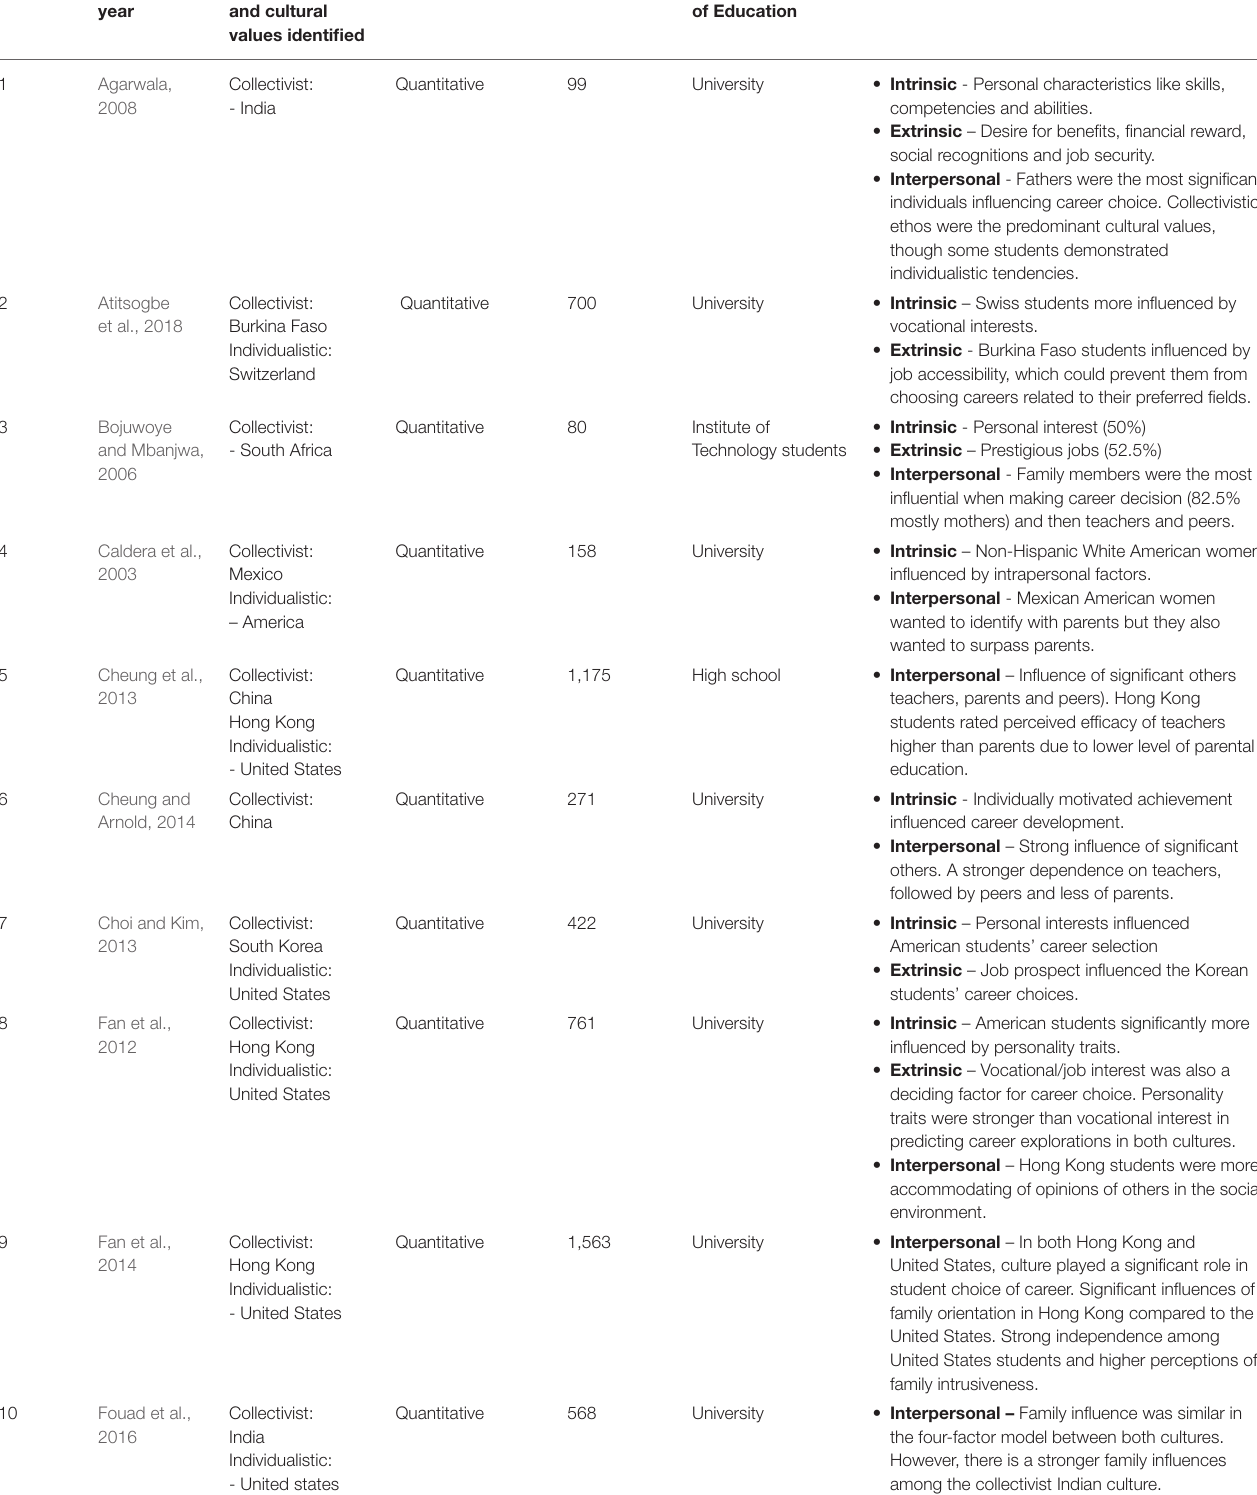
Table 1 | Summary of studies included in the